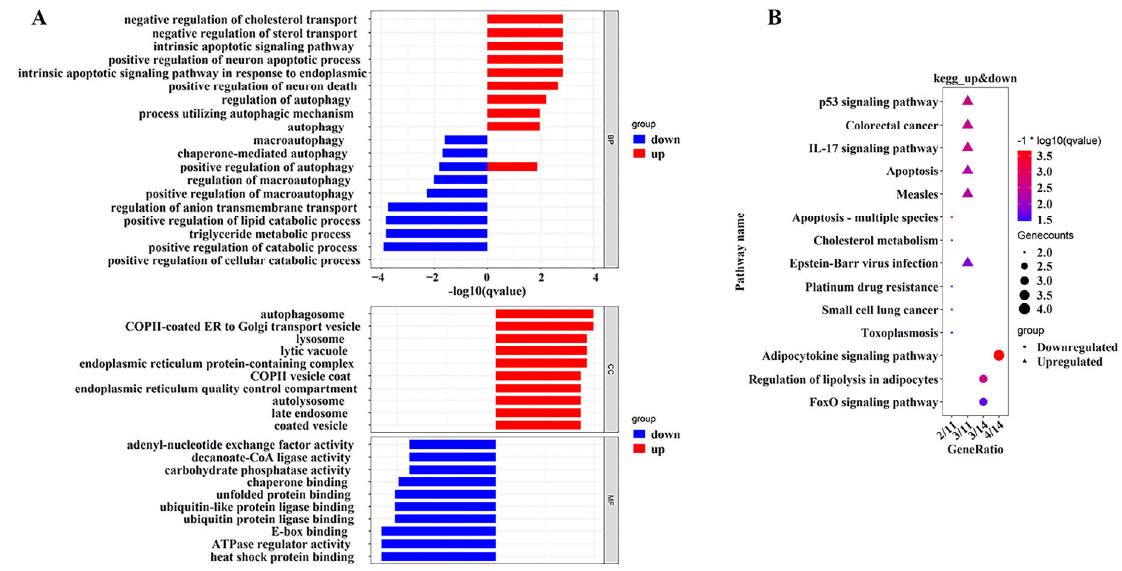
Figure 4. Functional enrichment analysis. ( A ) GO enrichment analyses of 31 common DEGs. The top 10 terms in each GO category (MF, molecular function; CC, cellular components; BP, biological processes). Red represents up-regulated genes and blue represents down-regulated genes; ( B ) KEGG enrichment analyses of 31 common DEGs. All significant KEGG pathways. The cut-off standard is FDR < 0.05. The color represents the FDR of this enrichment pathway, and the red represents a more prominent FDR. Gene ratio refers to the proportion of genes enriched in each pathway. Triangles represent upregulated genes, and dots represent downregulated genes.